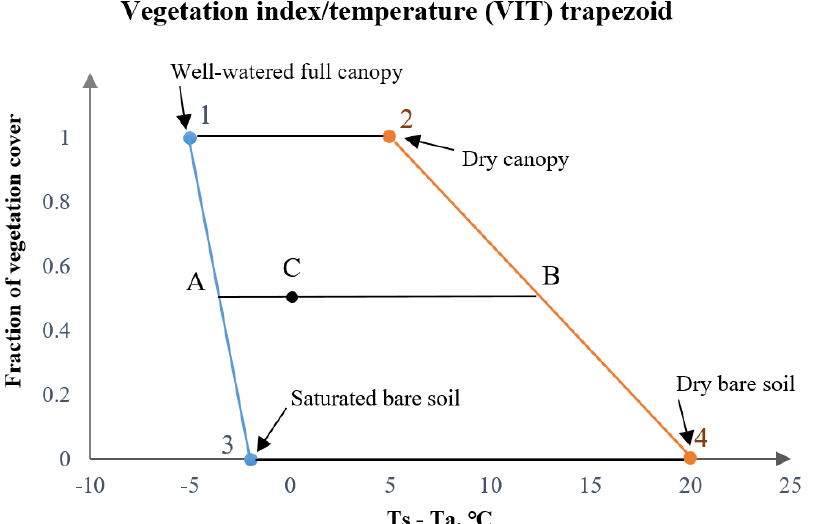
Figure 2. Illustration of the Vegetation Index/Temperature (VIT) trapezoid method. The x -axis shows surface–air temperature difference (Ts − Ta; °C) and the y -axis is a fraction of vegetation cover. Points 1, 2, 3, and 4 are theoretical extremes of the VIT trapezoid.